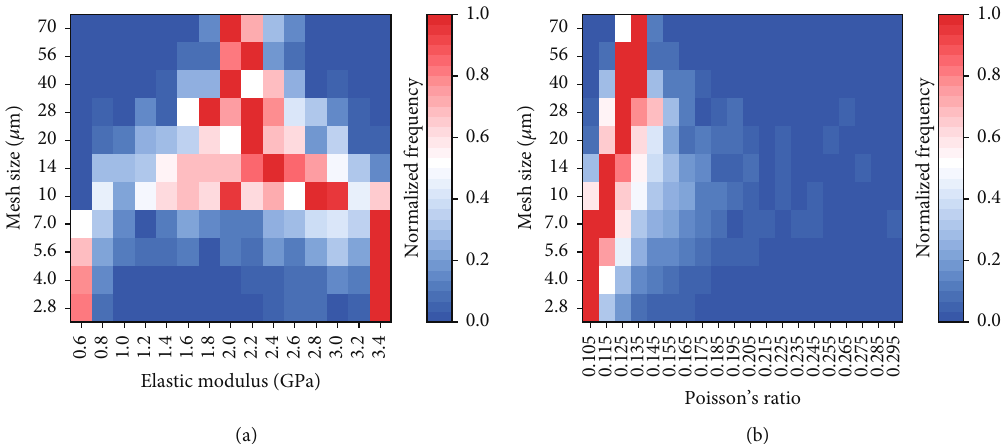
Figure 3: Hot maps of the probability density distributions (PDD) of the (a) elastic modulus and (b) Poisson ’ s ratio of the S3-MRR at di ff erent mesh